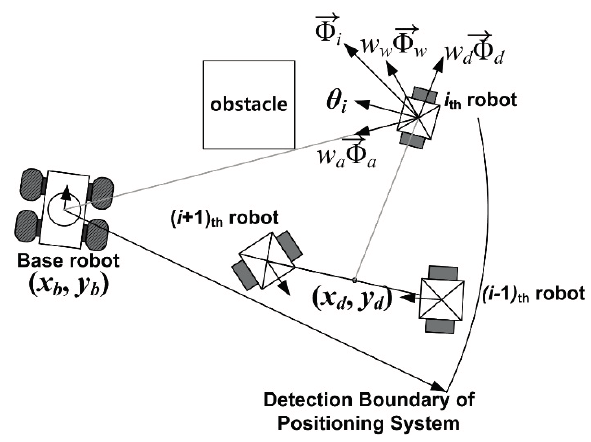
Figure 5. The combination of the basic behaviors.